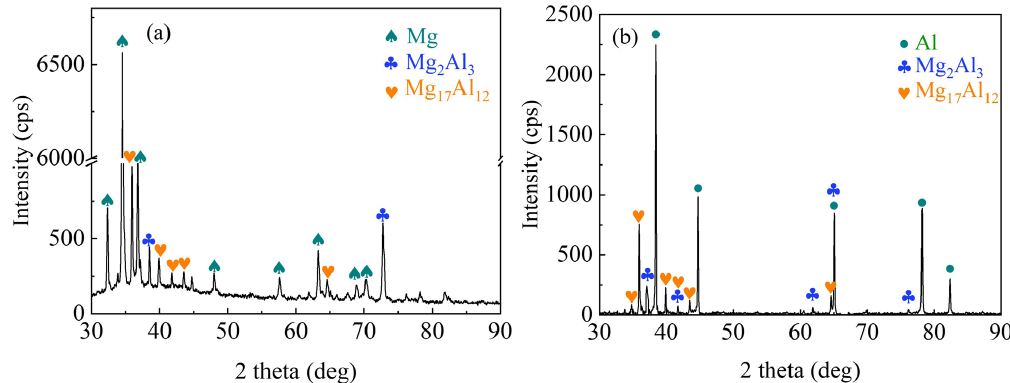
Figure 7. XRD results for welded joint fracture (a) XRD spectrum from the Mg side (b) XRD spectrum from the Al side.